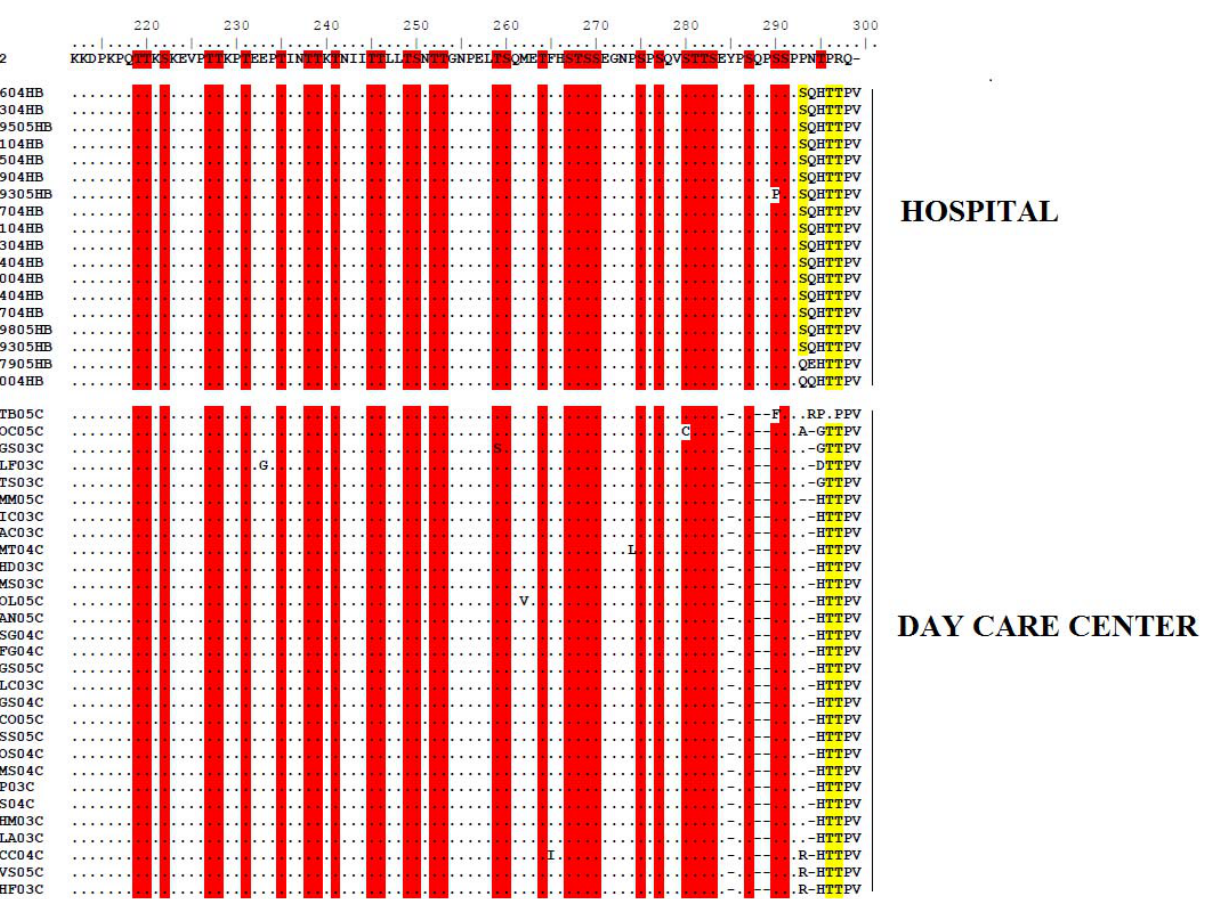
Figure 2. Alignment of deduced amino acid sequence of the G protein of HRSV GA1 genotype strains isolated in São José do Rio Preto-SP. Alignments are shown relative to the sequence of prototype strain A2. The amino acids shown correspond to positions 212 to 298 of the second hypervariable region of HRSVA strain A2 G protein. The alignment was done by the Clustal W algorithm running with BioEdit. Identical residues are represented as dots. Potential O-glycosylation sites conserved between HRSVA strain A2 and SJRP GA1 isolates are shaded in red. Potential O-glycosylation sites present only on SJRP GA1 isolates are shaded in